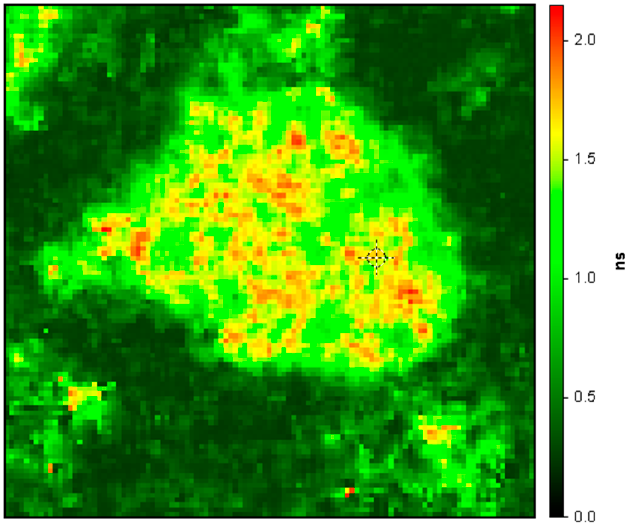
Figure 2. Close-up of druse in Figure 1 depicted in false color with the colors corresponding to the amplitude-weighted average fluorescence lifetimes (two component fit) of the individual pixels in nanoseconds (ns, vertical axis).